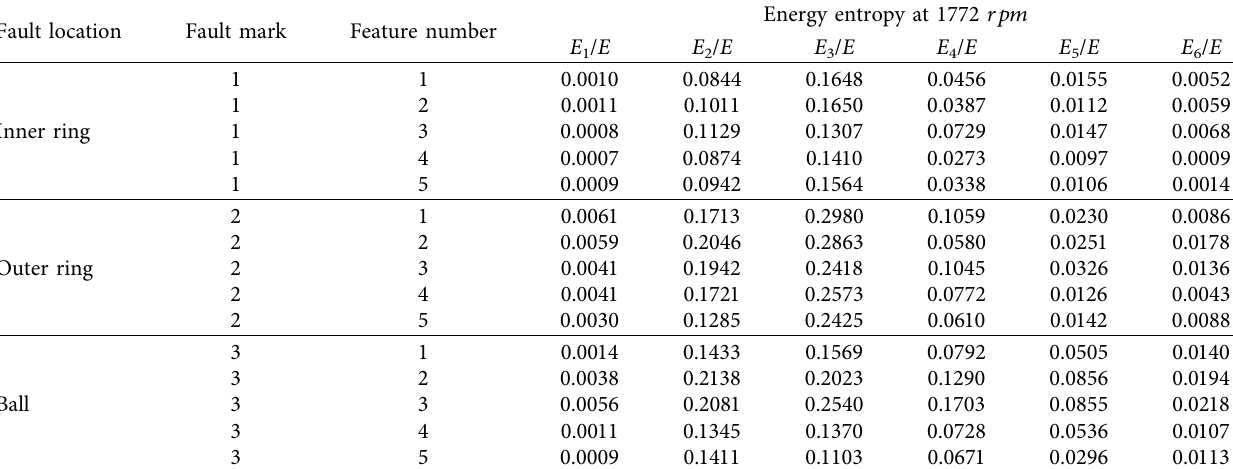
Table 3: Energy entropy at 1772 rpm.